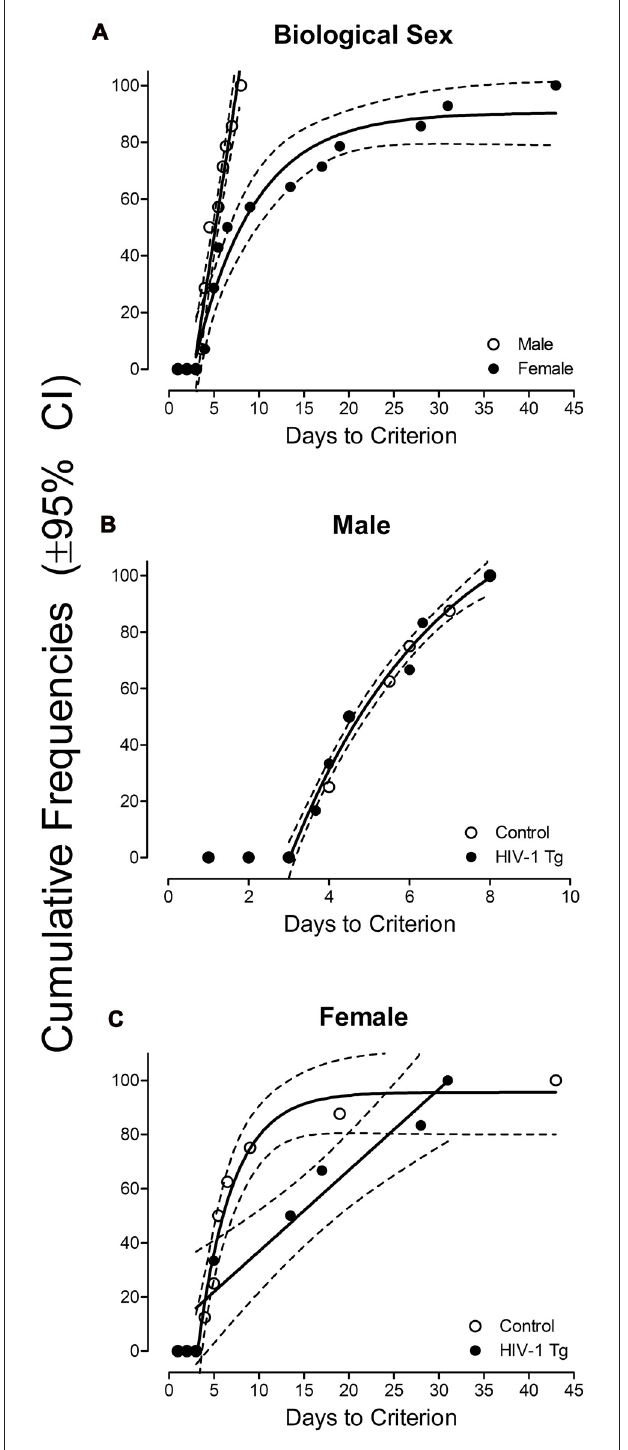
FIGURE 1 | (A) The number of sessions required to meet criterion (at least 60 reinforcers for three consecutive or five non-consecutive days) in the shaping task is presented as a function of biological sex, representing both HIV-1 Tg and control animals by collapsing across genotype ( ± 95% CI). A first-order polynomial provided a well-described fit for male animals ( R 2 : 0.95),